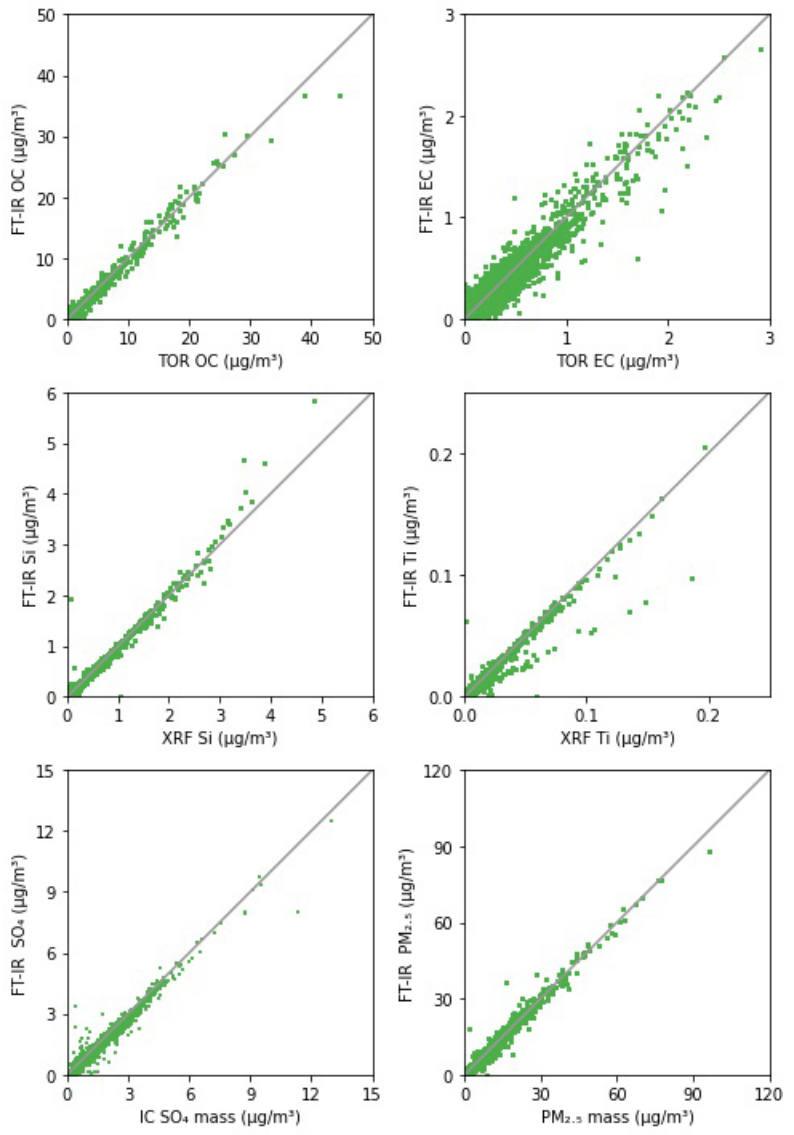
Figure 4. Comparison of predicted FT-IR OC, EC, Si, Ti, SO 4 , and mass concentrations using the multilevel model against their reference measurements. Each subplot contains all 19608 samples collected in the year